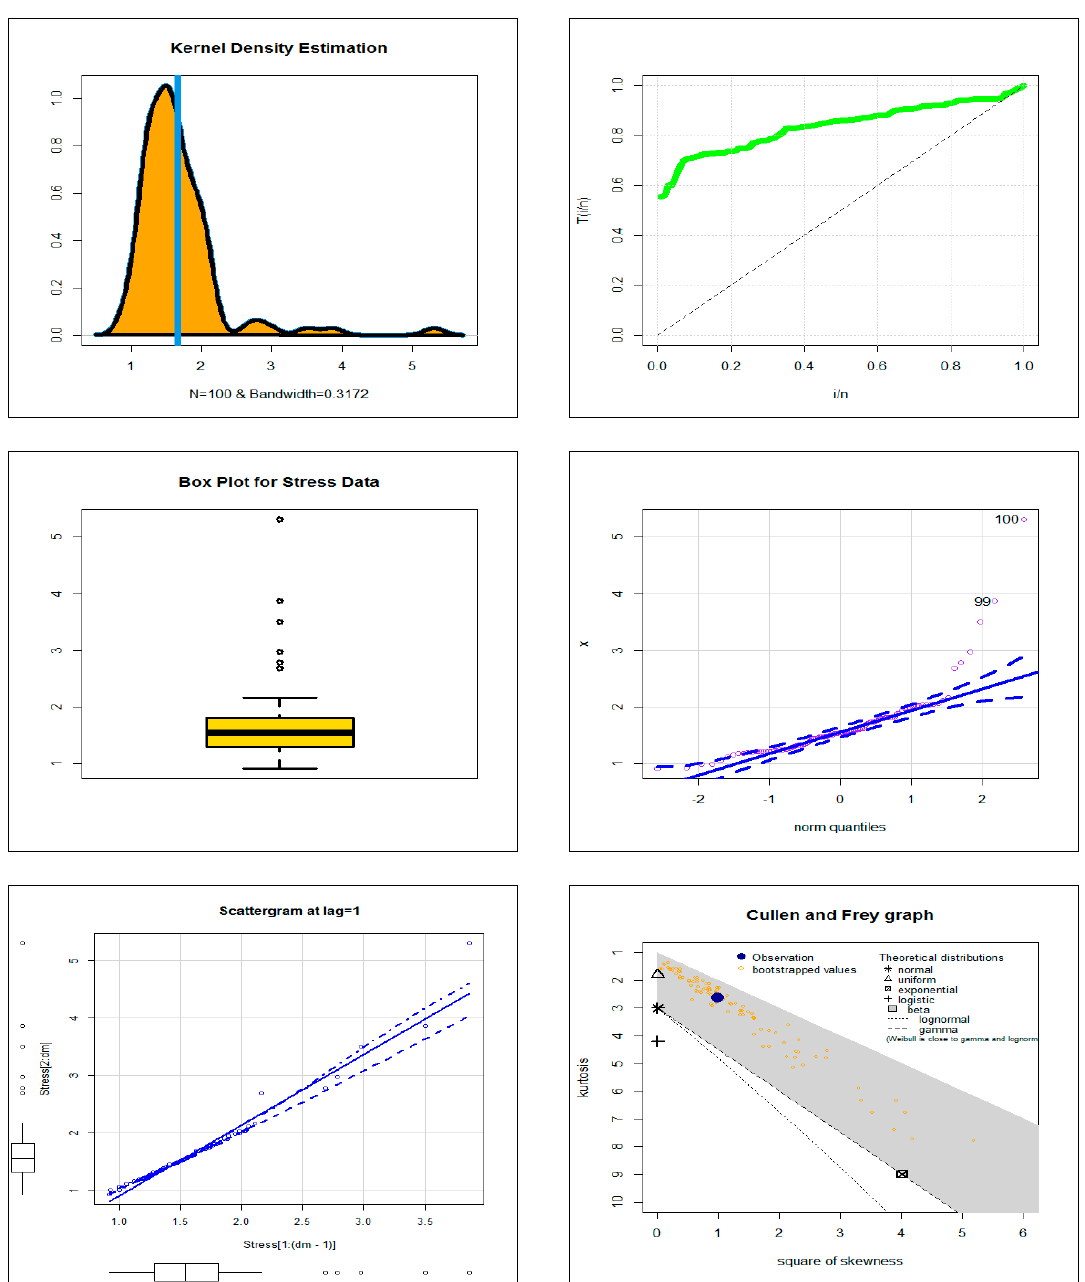
Figure 1. The NKDE panel (the first row, left panel), the TTT panel (the first row, right panel), the box panel (the second row, left panel), the Q-Q panel (the second row, right panel), scattergram panel (the third row, left panel), and the skewness-kurtosis panel (the third row, right panel) for the breaking stress of carbon fibers data.